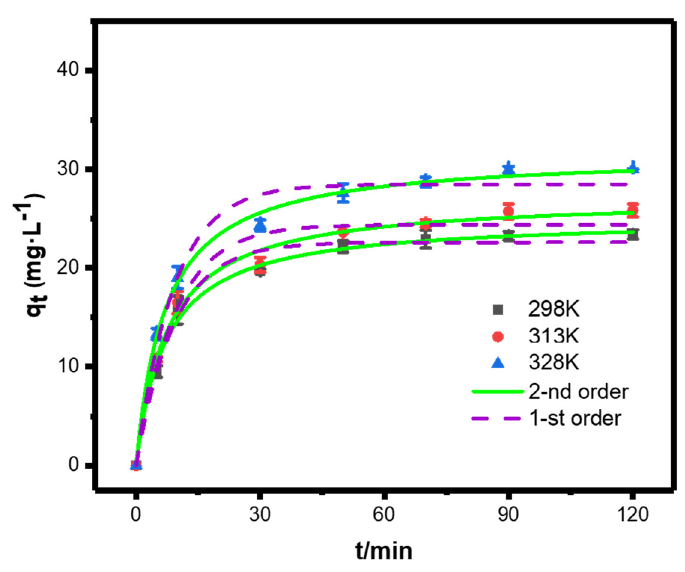
Figure 8. Pseudo first-order and pseudo second-order kinetic model fitting of the adsorption kinetics of SP@nZVI at different temperatures. Table 6. Kinetic model fitting constants at different temperatures.